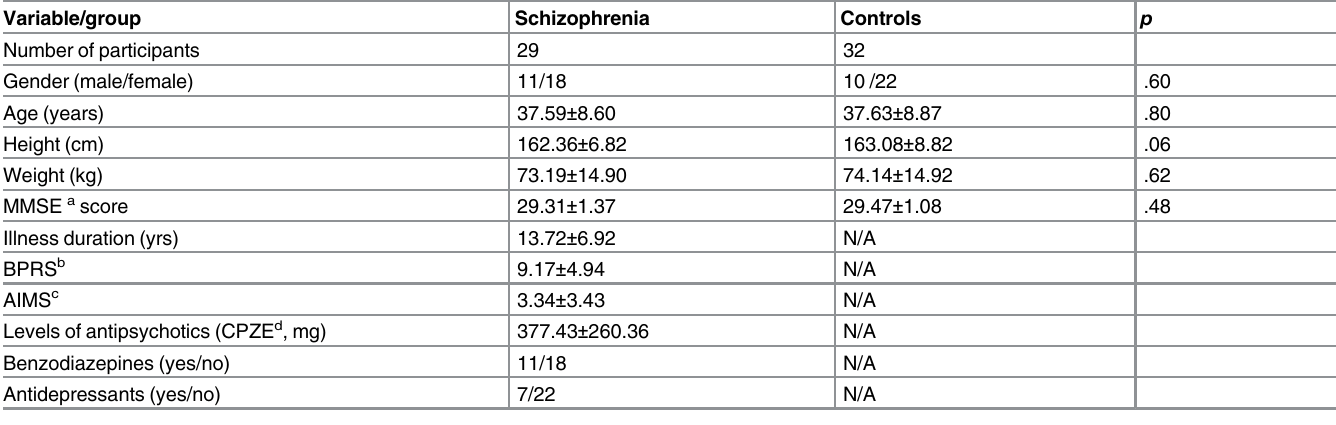
Table 1. Demographic data of